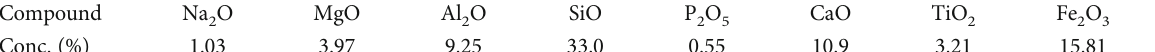
Table 3: The composition (wt%) of red rock sample calcined at 1000 ° C, pH of 10, and 0.32-250 μ m. O MgO Al 2